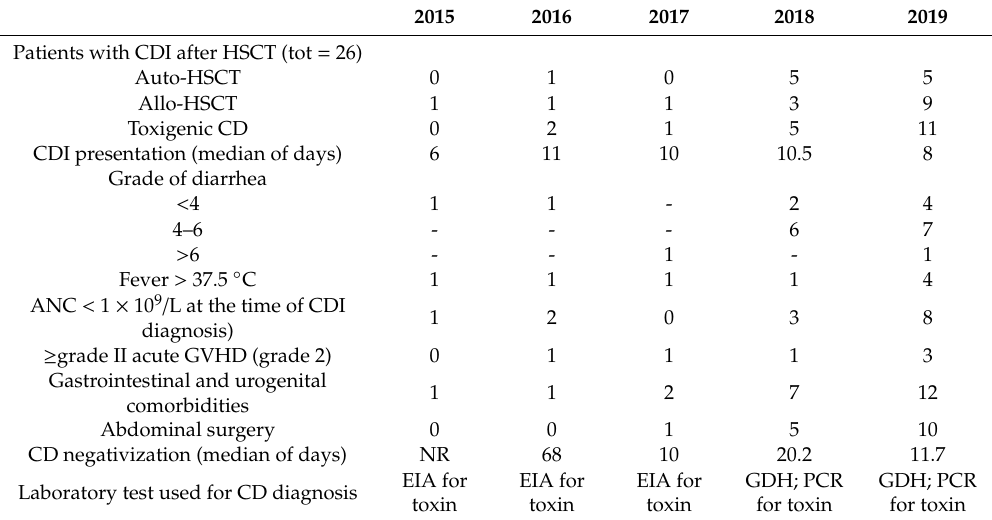
Table 3. Characteristic of patients with